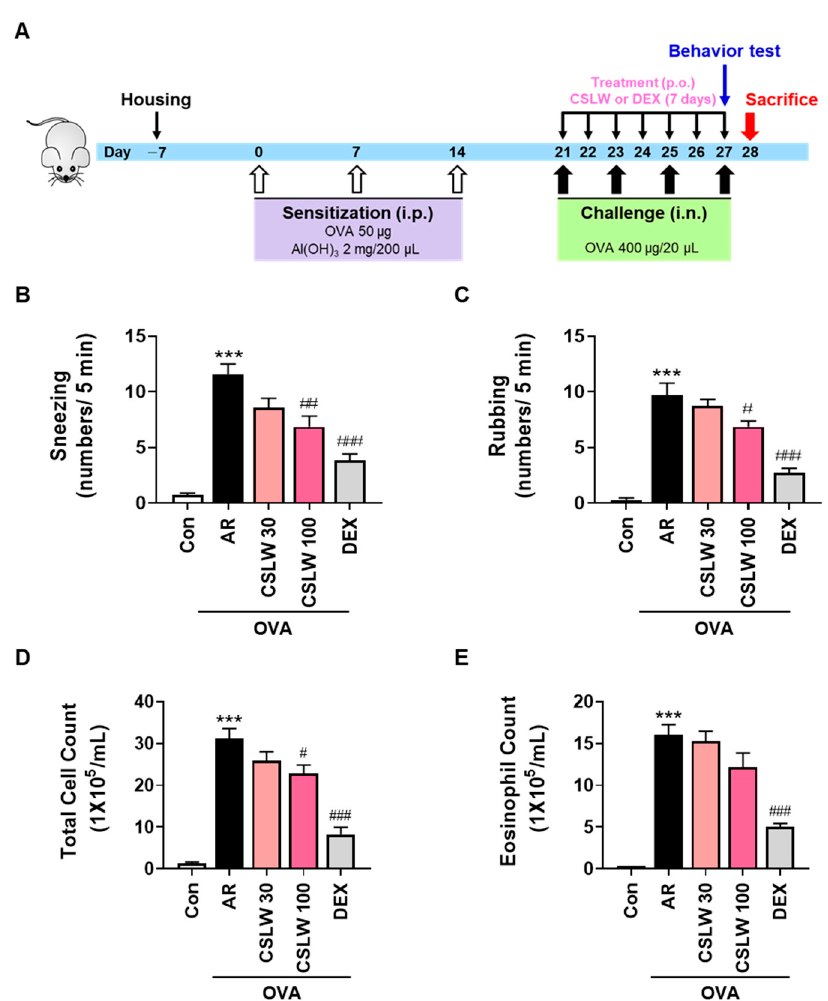
Figure 2. Effects of CSLW on nasal allergy symptoms and NALF parameters in an OVA − induced AR mouse model. ( A ) Experimental protocol for model development and treatment with CSLW. Once daily, the AR mice were orally treated CSLW or DEX, and then sacrificed for analysis 24 h after the final treatment. The number of sneezing ( B ) and rubbing ( C ) behaviors for nasal allergy symptoms were recorded after the last OVA intranasal treatment on day 28. Total cell ( D ) and eosinophil counts ( E ) were counted in the NALF of AR mice with or without CSLW treatment. The values are expressed as the means ± SD ( n = 7 mice per group). *** p < 0.001 compared with the Con (non − sensitized); # p < 0.05, ## p < 0.01, and ### p < 0.001 compared with the AR group. AR, allergic rhinitis; OVA, ovalbumin; CSLW, Caesalpinia sappan Linn. heartwood water extract; DEX, dexamethasone;